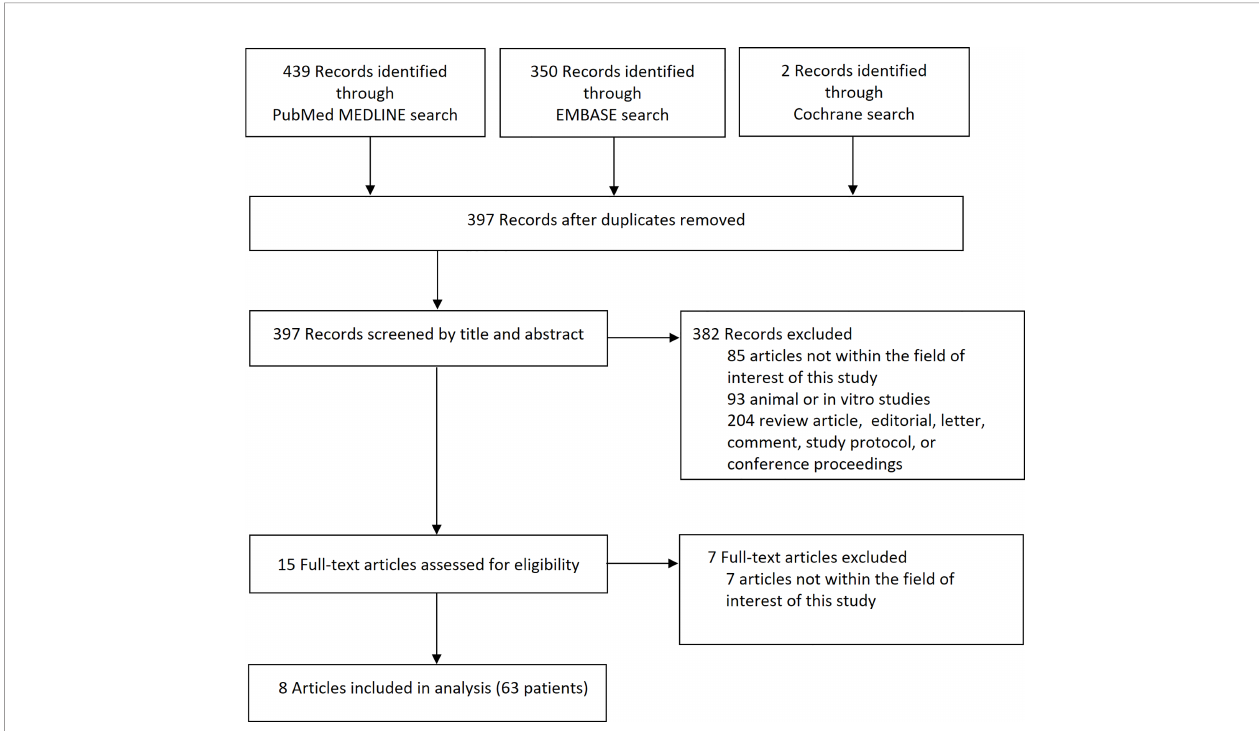
FIGURE 1 | Flow diagram of the article selection process. An article may have been excluded for multiple reasons, but only 1 major reason per article is